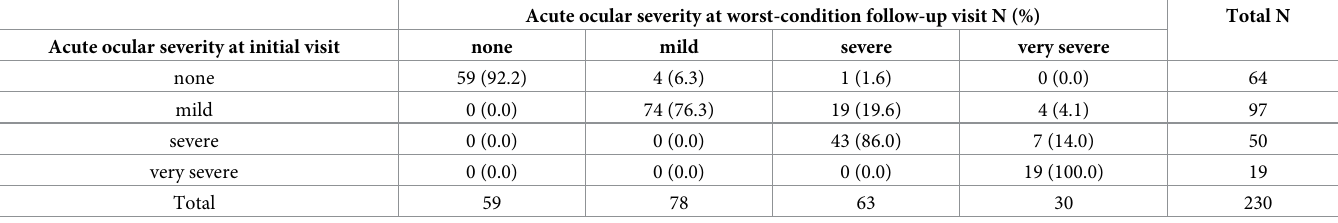
Table 1. The change of acute ocular severity. Acute ocular severity at initial presentation was graded as acute ocular severity at worst-condition follow-up visit.